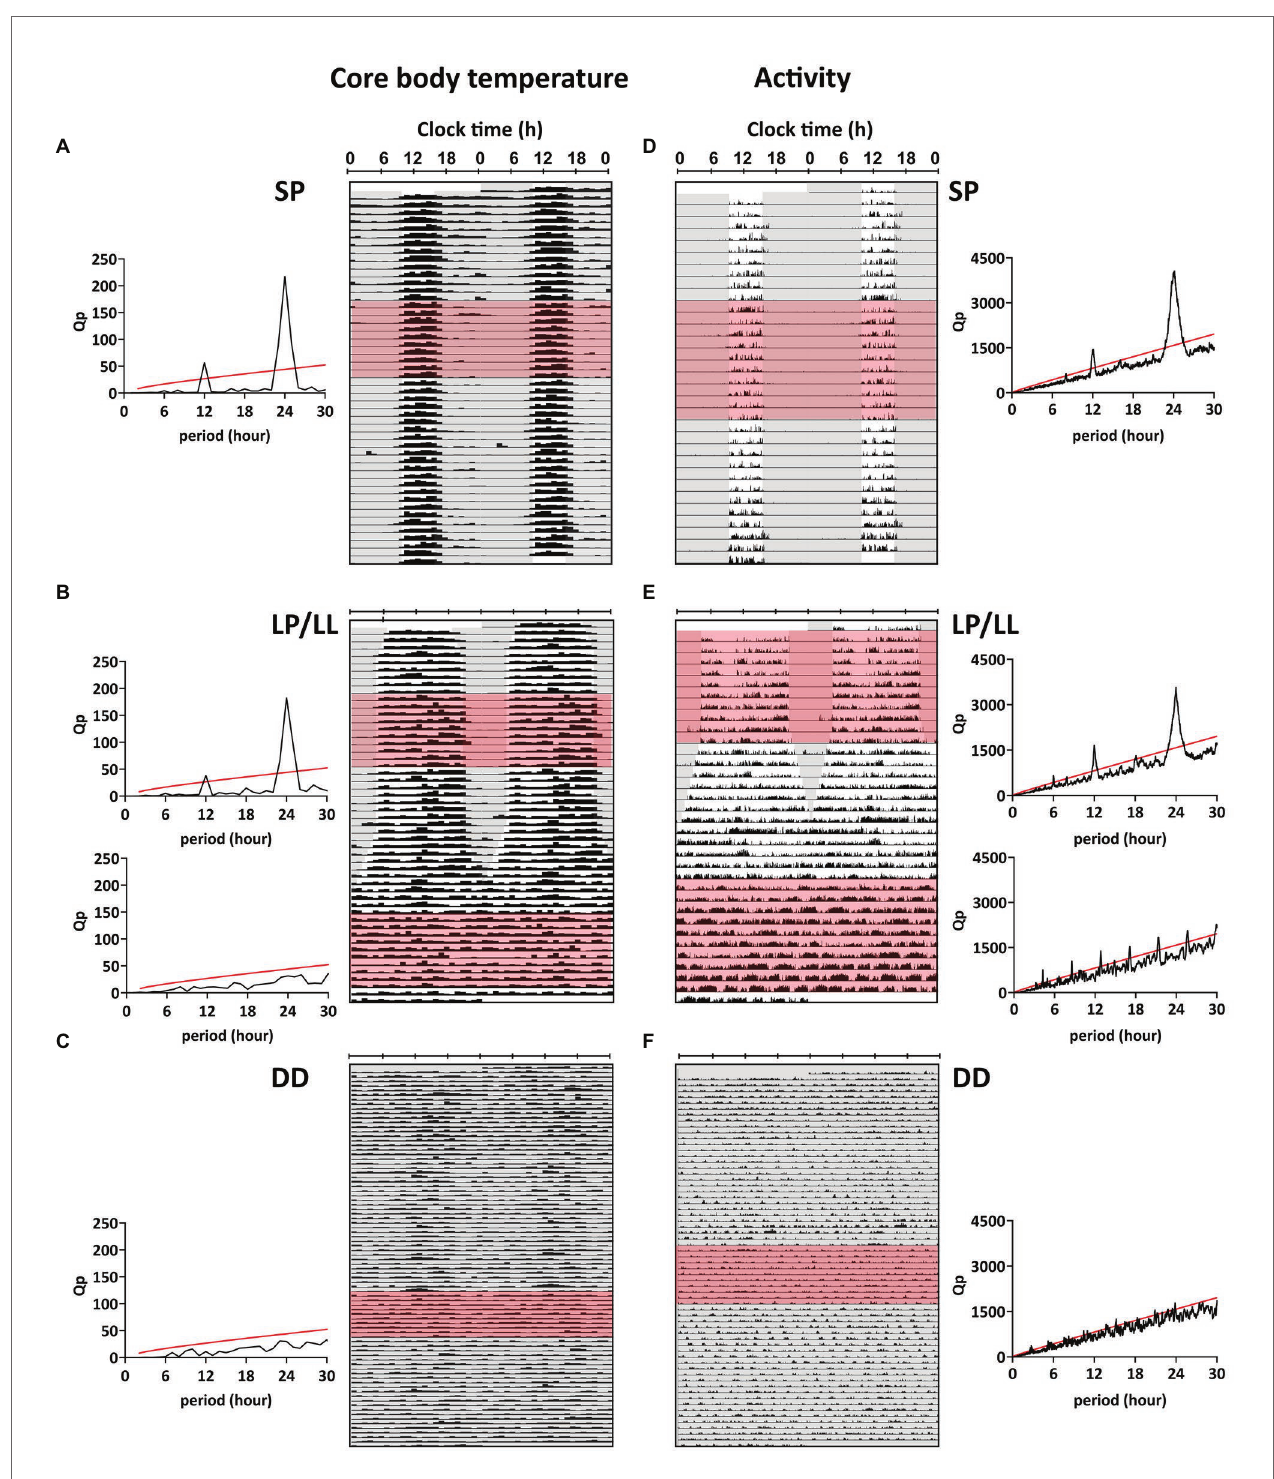
FIGURE 2 | Representative double-plotted actograms for body temperature ( T b ) and activity. (A-C) T b was plotted actogram-like between 40 and 42 ° C for representative birds from each group (bird IDs A : SP3, B : LP/LL11, C : DD3). (D–F) Actograms for normalized activity were plotted between 0 and 1 for representative birds from each group (bird IDs D : SP6, E : LP/LL15, F : DD2). χ 2 -periodograms were plotted for 10 consecutive days in each light treatment (red shading in actograms) and are displayed next to the respective recordings. Values above the red line indicate that the cycle period was significant ( p < 0.05). Additional actograms and periodograms can be found in Supplementary Figures S1–S3